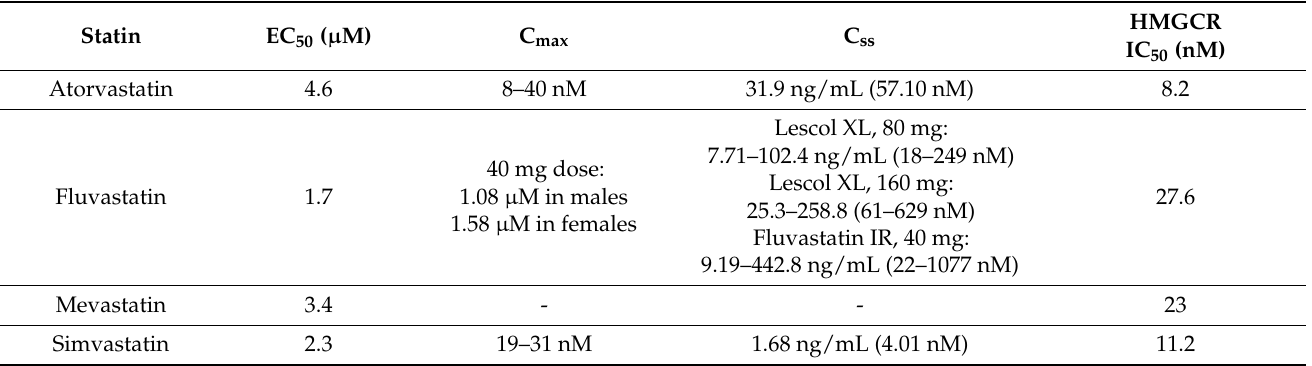
Table 5. Comparison of effective in vitro concentrations and serum concentrations of